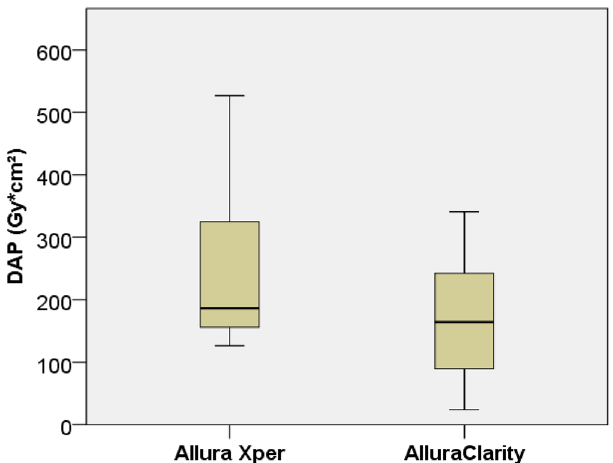
Figure 1. Box plot showing the mean cumulative dose area product (DAP) during adrenal vein sampling (AVS) for Allura Xper (235.1 ± 113.1 Gycm 2 ) and AlluraClarity (170.1 ± 94.5 Gycm 2 ). DAP includes both digital subtraction angiography and digital